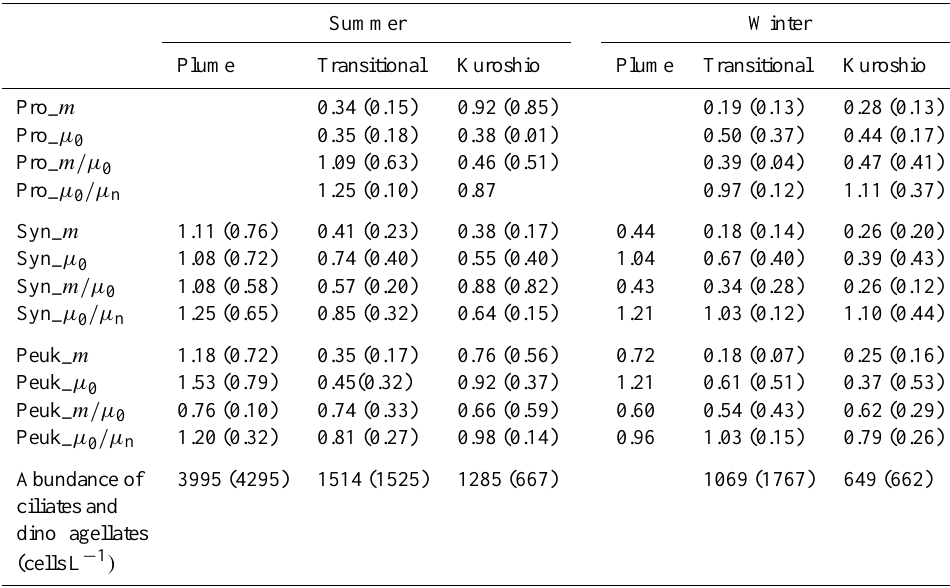
Table 3. Comparison of m , µ , m/µ 0 , and µ 0 /µ n of three populations in plume, transitional and Kuroshio regions in summer and winter.